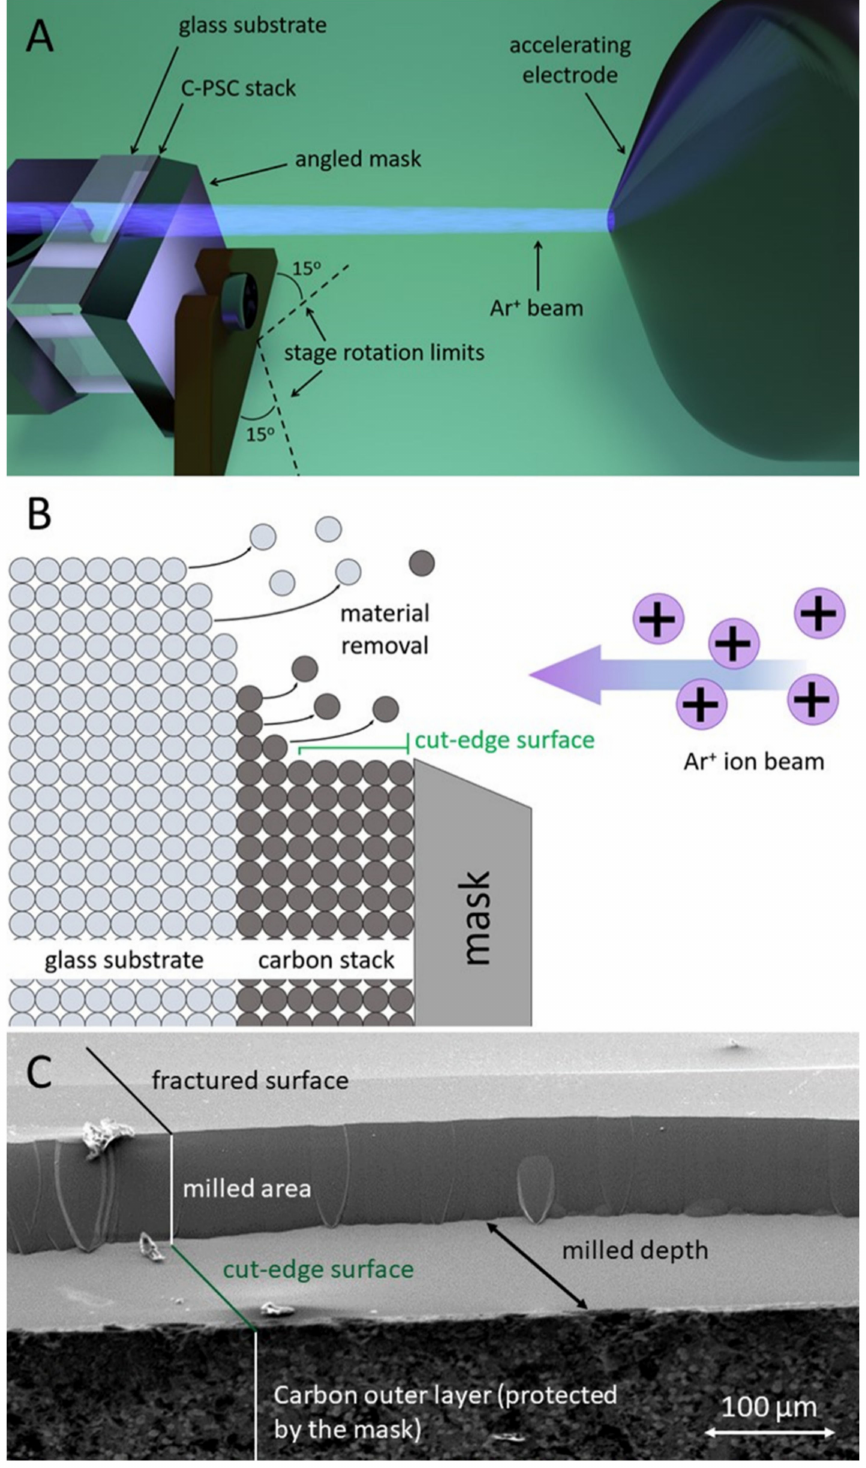
Figure 2. ( A ) Representation of sample positioning and ion source inside the BBIM chamber; ( B ) side view schematic representing the milling of the sample; ( C ) top view SEM observation of the sample post BBIM (4 kV for 1.5